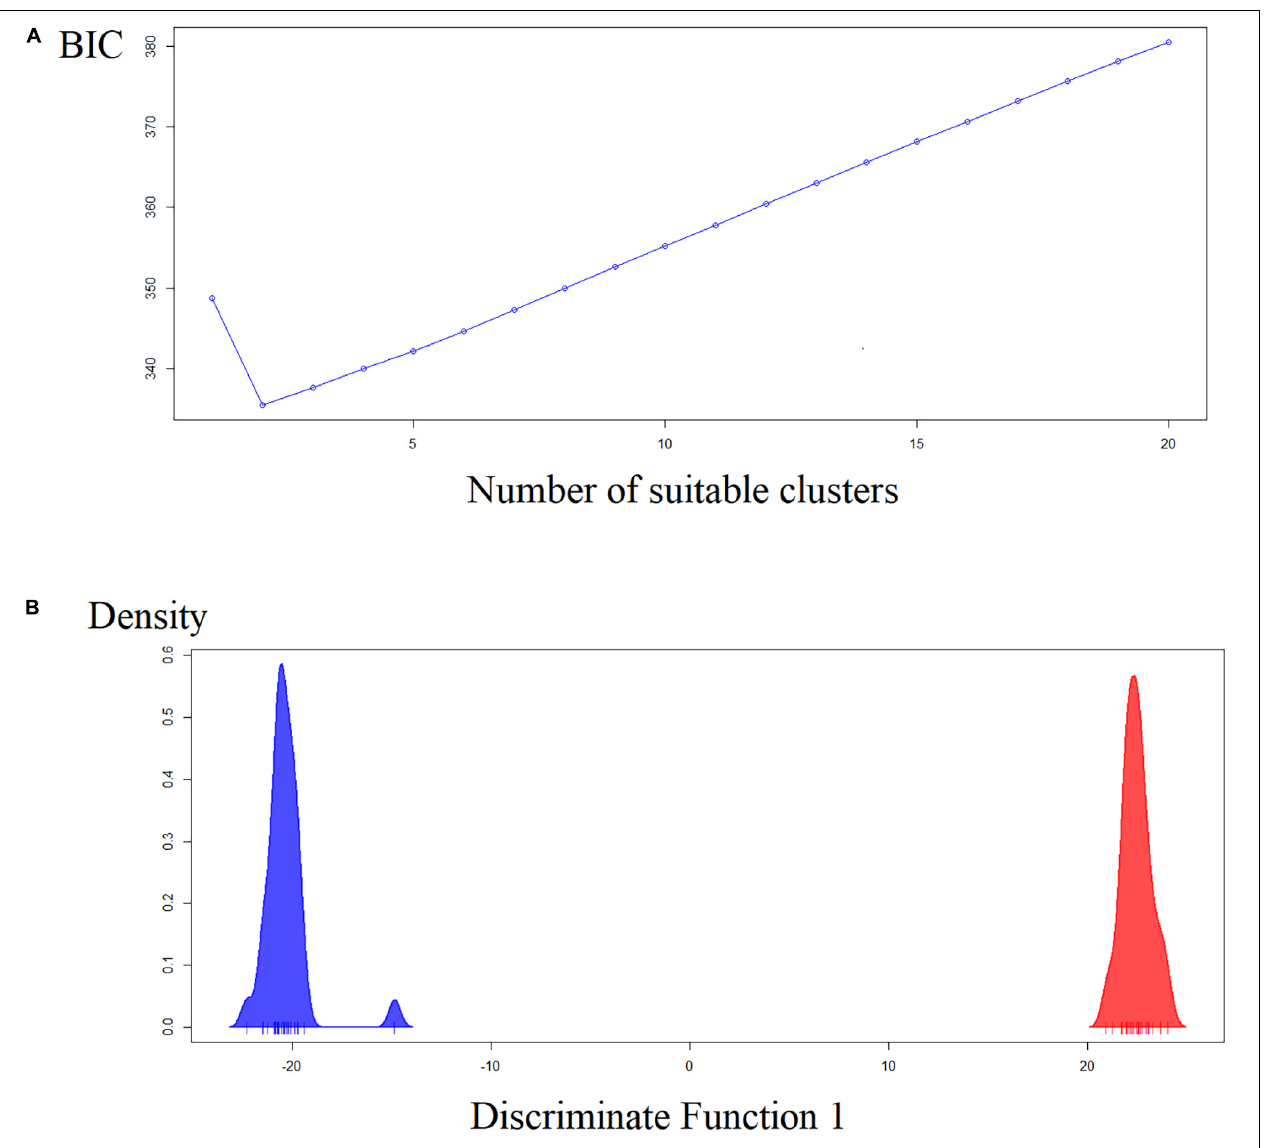
FIGURE 4 | Discriminant analysis of principal components (dPCA). (A) Likely number of clusters estimated by Bayesian Criterion (BIC). (B) Ordination showing the two clusters along the X -axis.